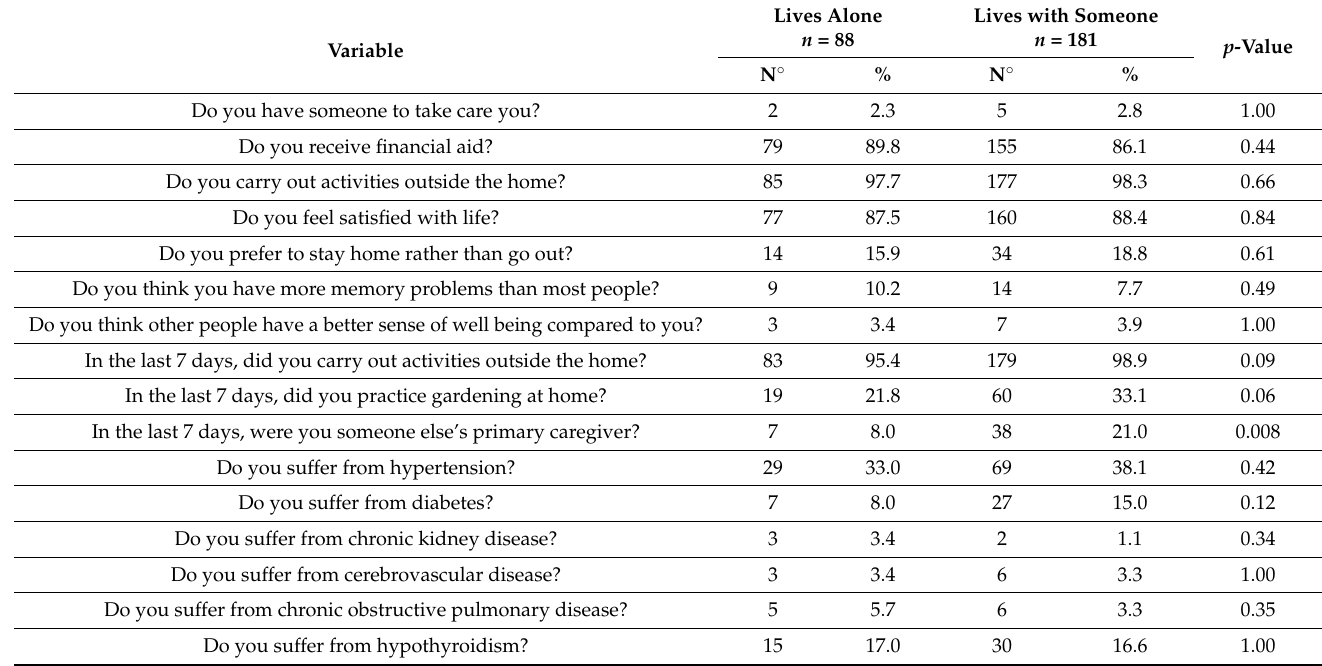
Lives Alone Lives with Someone n = 88 n =